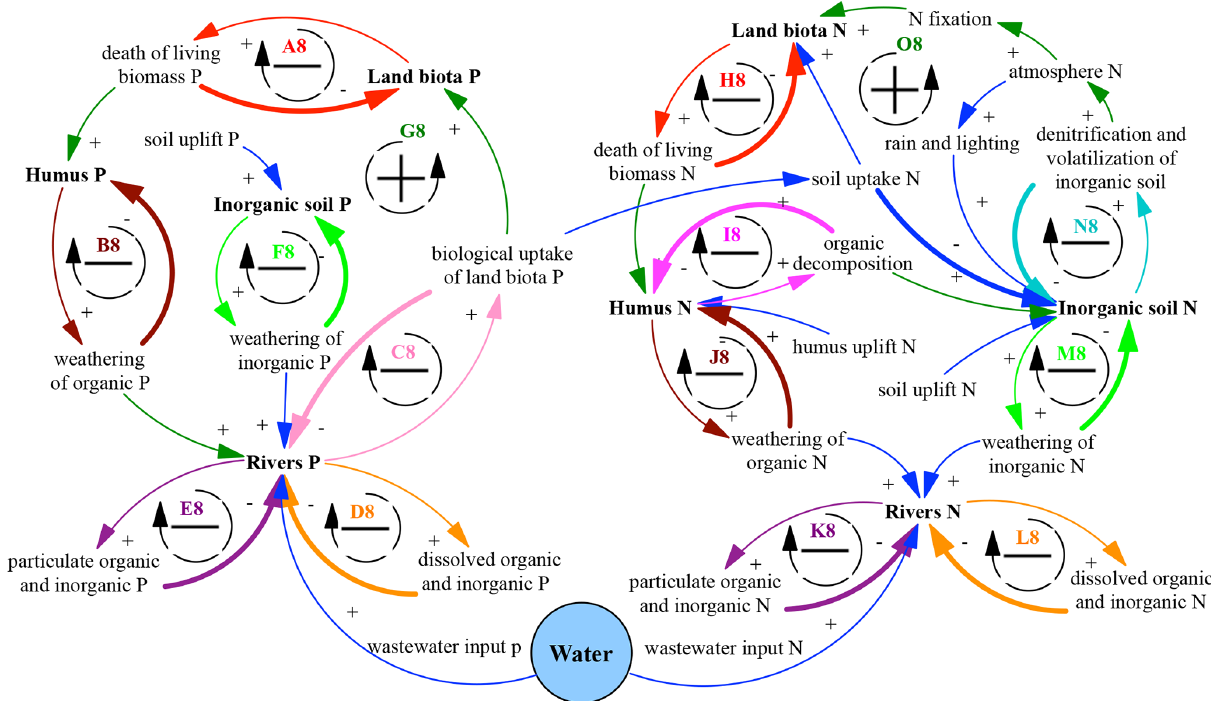
Figure 10. CLD in the nutrient sector.